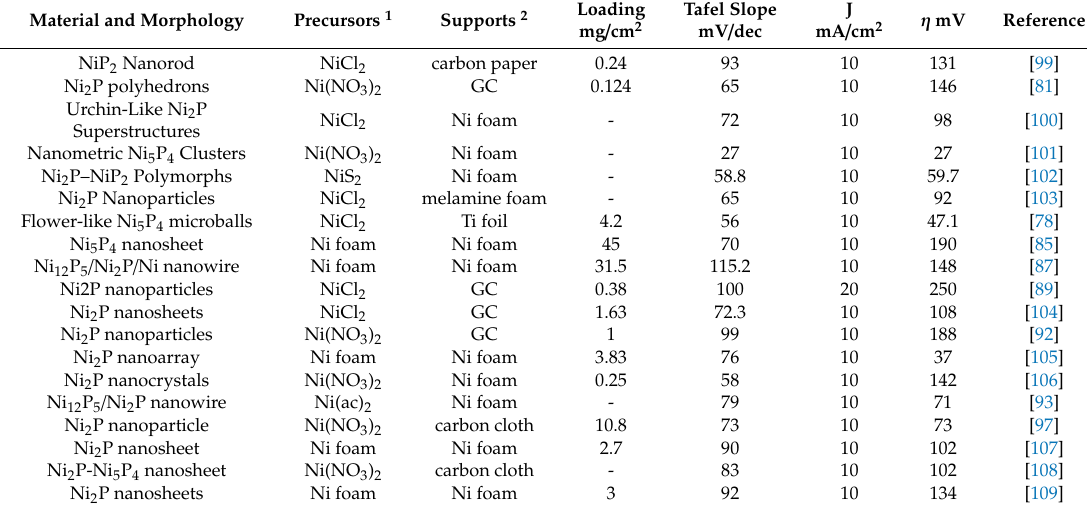
Table 4. Summary of the nickel phosphide electrocatalysts prepared through thermal phosphidation with hypophosphite for HER in an alkaline